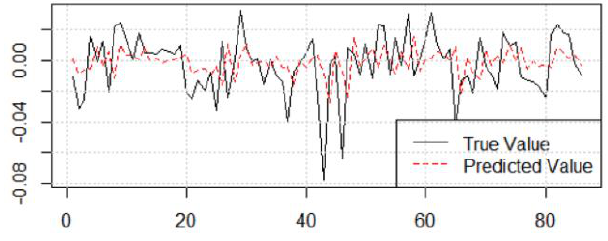
Figure 10: Plot of the true values against the values predicted by the rolling window forecasting